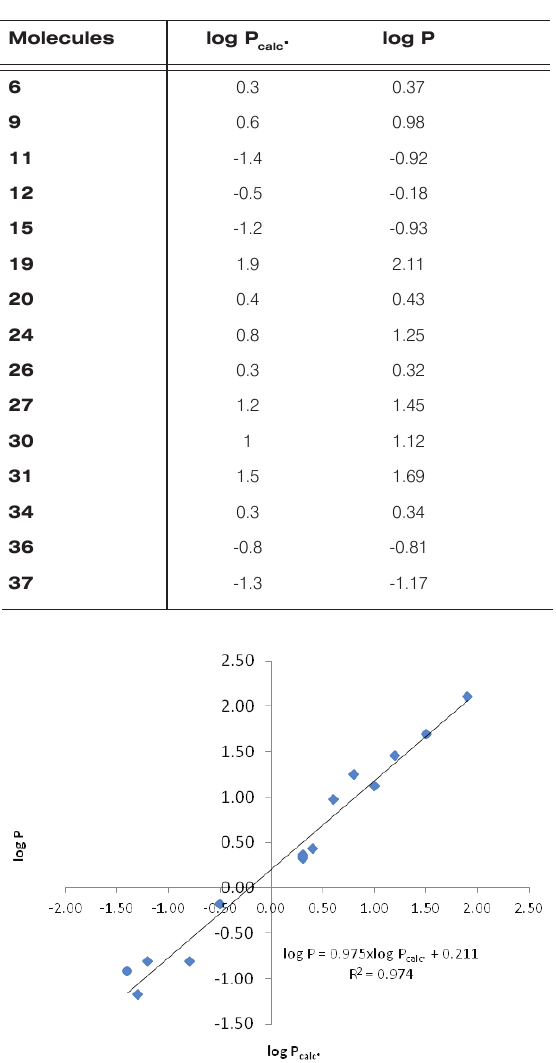
Table 6. Table 7. Calculated values of log P by similarity clusters, for the